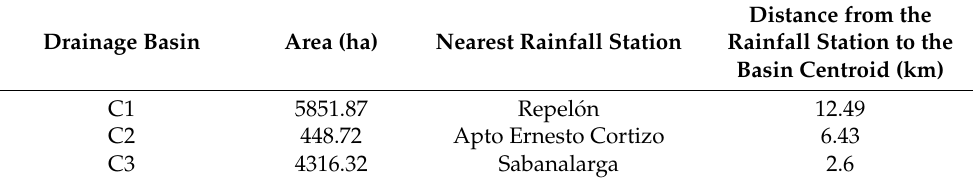
Figure 4. Determination of antecedent moisture for drainage basins C1, C2 and C3. Spatial distribu- tion of precipitation by using spline, kriging, and IDW method. Table 5. Summary of drainage basin information